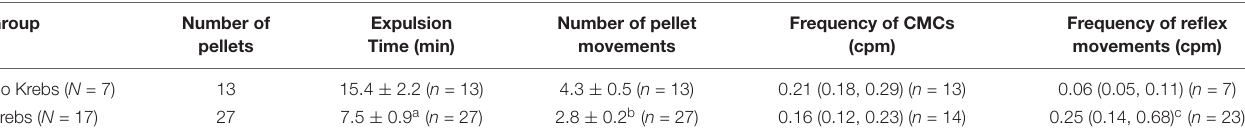
TABLE 3 | Frequencies of motor patterns with and without Krebs perfusion.